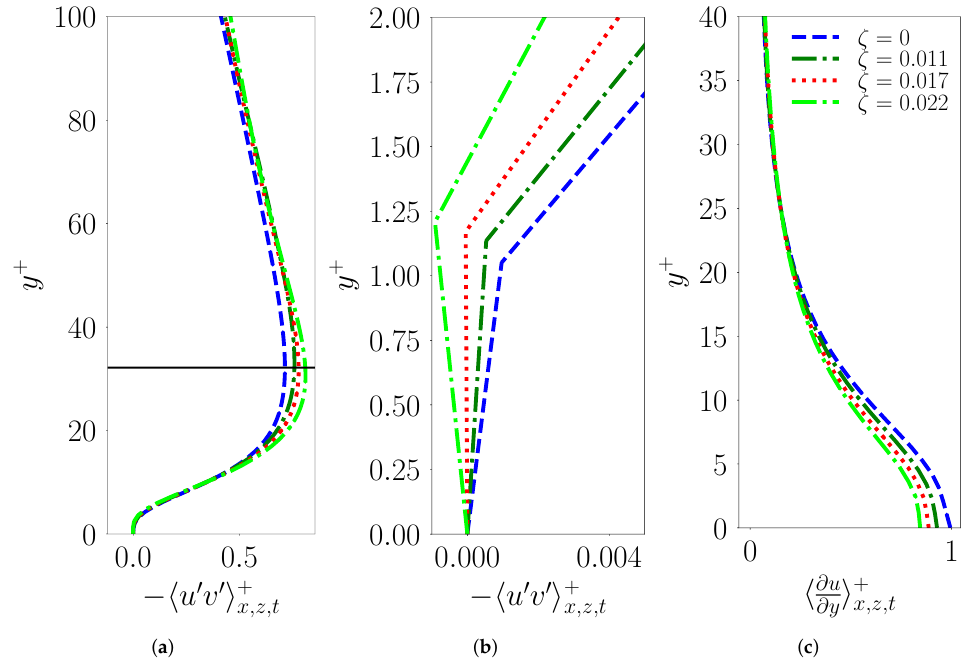
+ + u (cid:48) v (cid:48) u (cid:48) v (cid:48) , ( b ) covariance (zoomed near the x , z , t x , z , t (cid:104) (cid:105) (cid:104) (cid:105) u + / dy + . The black horizontal line (cid:104) (cid:105) x , z , t + u (cid:48) v (cid:48) for the different ζ . Note that the x , z , t (cid:104) (cid:105)